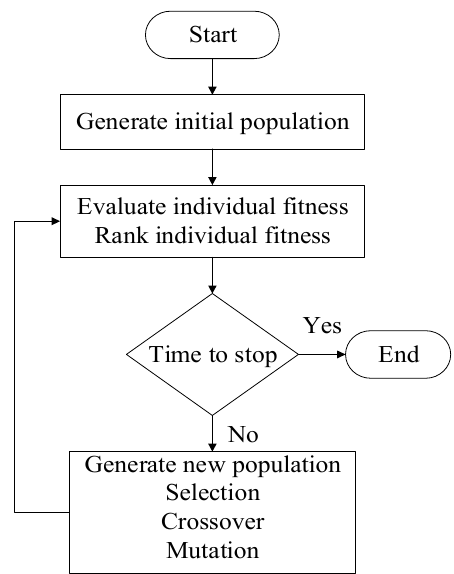
Figure 4. Genetic algorithm (GA) optimization.